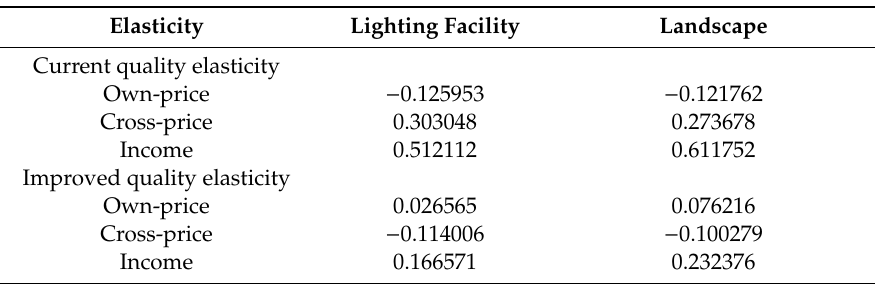
Table 4. Elasticity estimates.